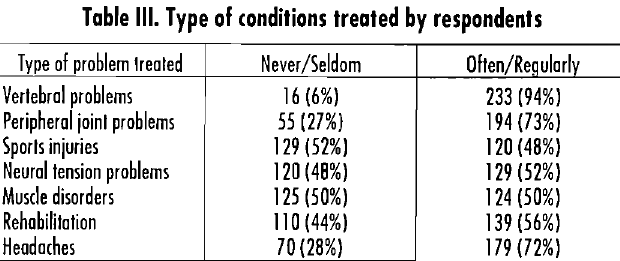
Table III. Type of conditions treated by respondents